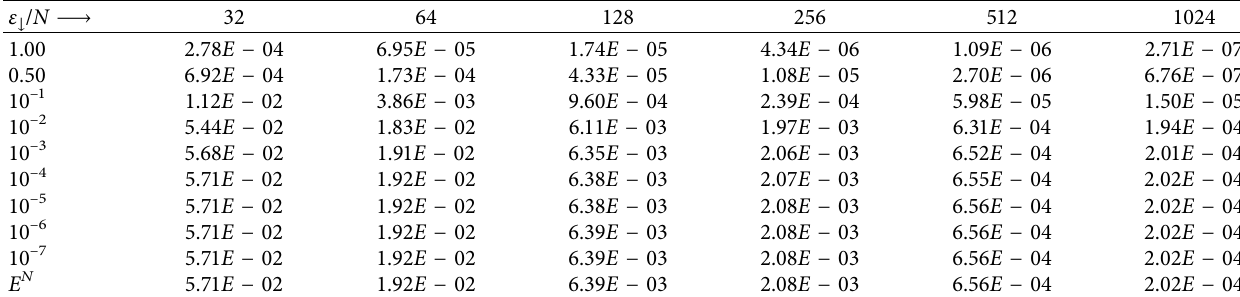
Figure 2: Plot of the solutions of Example 1 for ε � 0.1 and N � 64. Table 3: Result of Example 2 (maximum pointwise error) for δ � η � 0.5 ∗ ε .